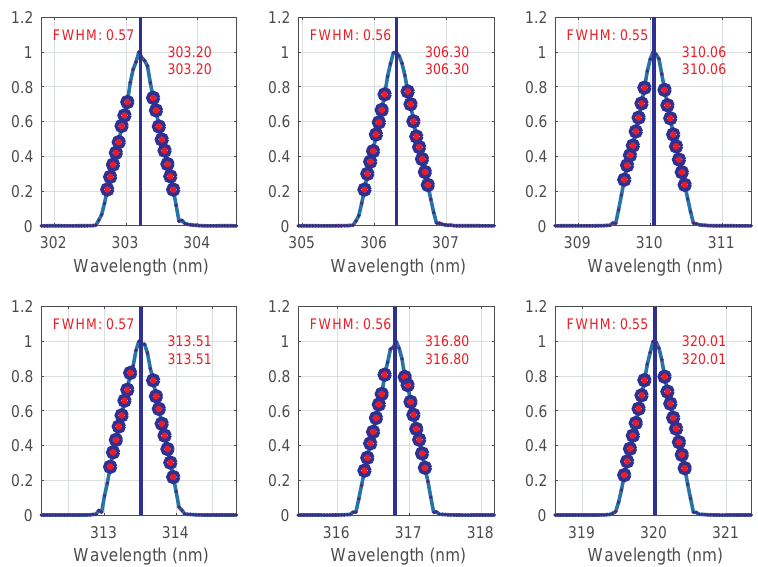
Figure 1. Results of Brewer measurements in the ozone mode obtained while the laser wavelength was changed every 0.04nm. The central wavelength and the FWHM calculated are displayed in red using the same methodology of the dispersion test.